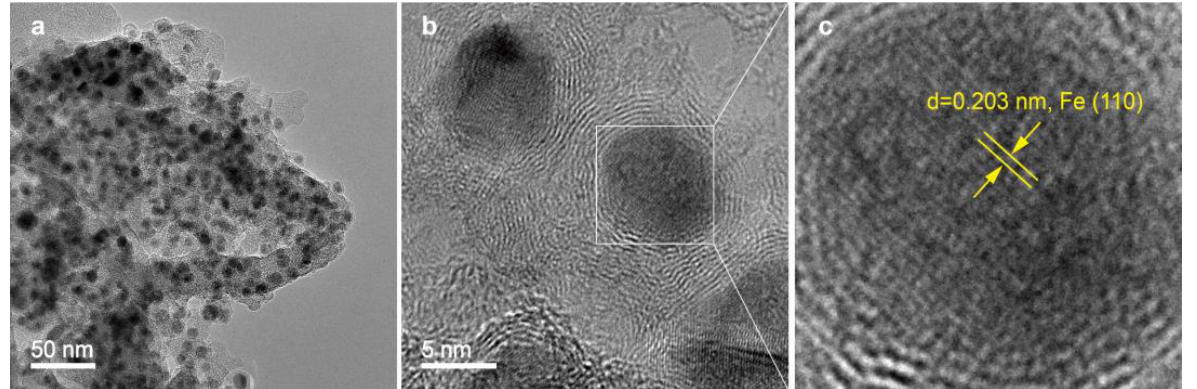
Figure 5. Microstructural characterizations of Fe@Fe-SAC after ADT. ( a ) TEM image and ( b , c ) HRTEM image of Fe@Fe-SAC after ADT.